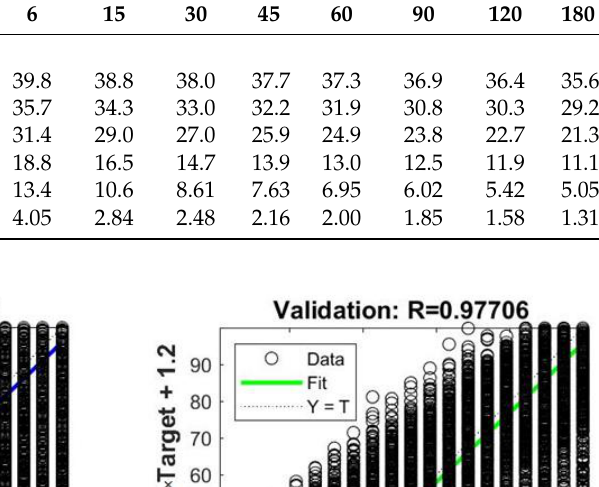
Table 1. Time dependence of stresses at different temperatures.